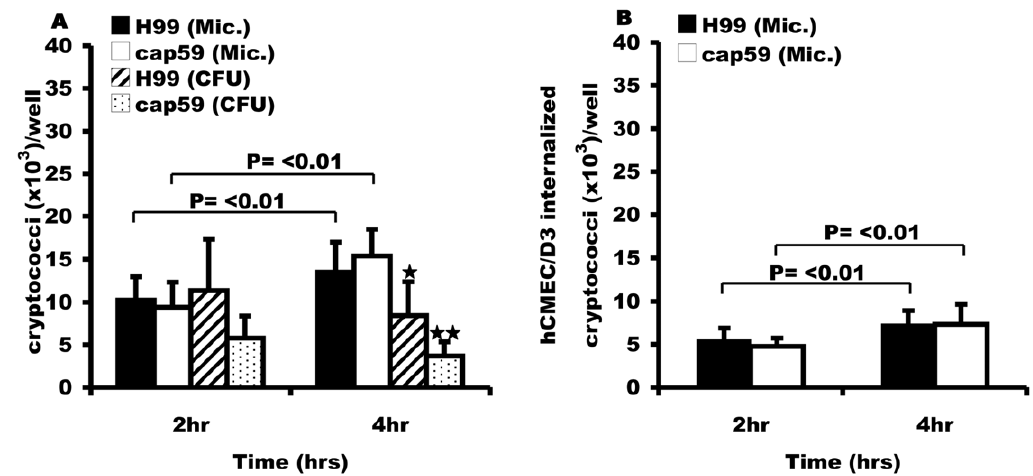
Figure 3. Binding and uptake of H99 and cap59 with human brain endothelial cell line, hCMEC/D3. Like bEnd3 cells, hCMEC/D3 cells were exposed to the C. neoformans serotype A isogenic strains, wild type H99 and acapsular derivative cap59 for 2 hr and 4 hr at 37 u C. Microscopic (Mic.) and live CFU counts were performed to determine the association and survival of cryptococci. (A) Association efficiency of H99 and cap59 cryptococci with hCMEC/D3 cells. As opposed to microscopic counts, live CFU counts showed a time dependent decrease in the number of associated cryptococci by 4 hr of incubation, w =P , 0.05 and ww =P , 0.01 for H99 and cap59 respectively, suggesting a drop in viability of the hCMEC/D3 associated H99 and cap59 cryptococci. There was no difference in association of encapsulated H99 and acapsular cap59, P=0.7 and 0.6 at 2 hr and 4 hr respectively. (B) Internalization of encapsulated H99 and acapsular cap59 cryptococci by human brain endothelial cell line, hCMEC/D3 cells. The internalized cryptococci and extracellular adherent were determined as in Figure 1. As with association, the number of phagocytosed cryptococci increased significantly in a time dependent manner, P=0.01 and , 0.01 for H99 and cap59 respectively. However, there was no difference in internalization of H99 and acapsular cap59 cryptococci, P=0.5 and 0.8 at 2 hr and 4 hr respectively. Error bars are standard error of the mean, n=6 repeats.